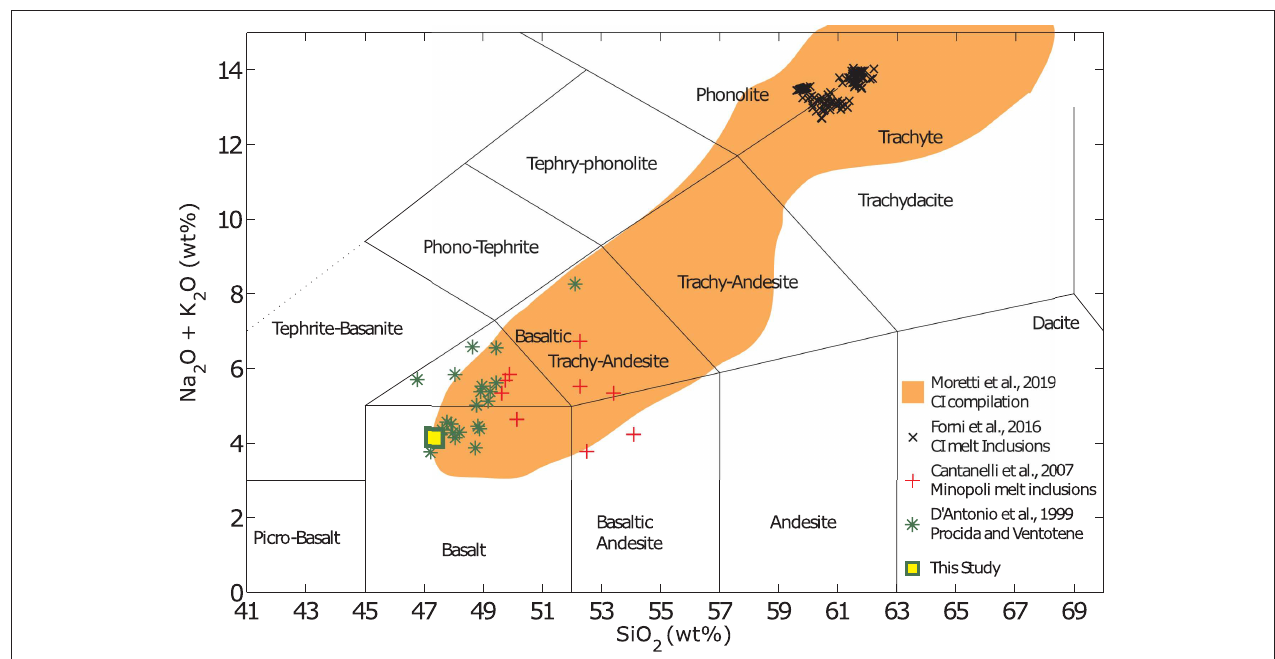
FIGURE 1 | Compilation of compositional analyses on eruptive products from the PVD. Summary of select compositions occurring within the PVD. Data are shown for the Campanian Ignimbrite (CI) eruption; compilation by Moretti et al. (2019) and Forni et al. (2018), as well as for melt inclusions and eruptive products of the Minopoli eruption ( Cannatelli et al., 2007) and lavas and xenoliths from Procida and Ventotene (D’antonio et al., 1999a). The composition used in this study is synthesized to represent the least evolved composition known to occur in the PVD.